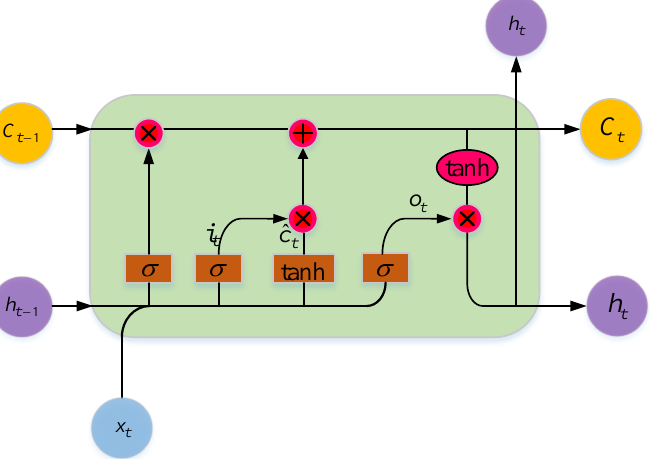
Figure 3. LSTM neural network structure.